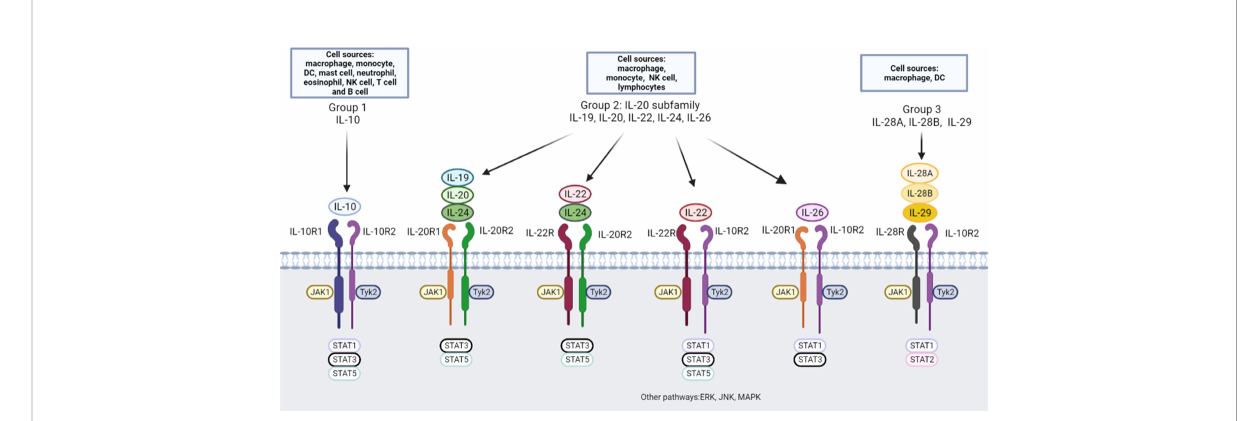
FIGURE 1 IL-10 family cytokines, receptors and downstream pathway. Nine cytokines in the IL-10 family have been identi fi ed, and these cytokines can be divided into three groups: the IL-10, IL-20 subfamily and group 3. DC, dendritic cells; NK cell, natural killer cell; JAK, Janus tyrosine kinase; Tyk, tyrosine kinase; STAT, signal transducer and activator of transcription; ERK, extracellular signal-regulated kinase; JNK, c-Jun N-terminal kinase; MAPK, mitogen-activated protein